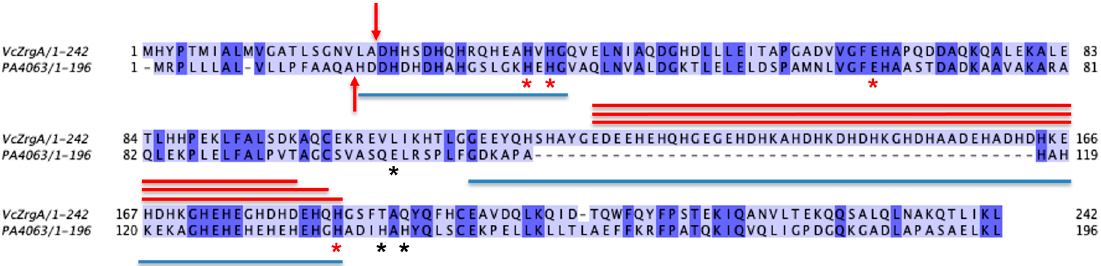
Figure 1. Sequence alignment of ZrgA homologues from V. cholerae (VcZrgA) and P. aeruginosa (PA4063). Arrows indicate predicted cleavage sites for the N-terminal periplasmic targeting se- quence [18,19]. Asterisks indicate zinc binding residues in PA4063 colored by binding site (site a, black; site b, red). Blue lines under the PA4063 sequence indicate unstructured regions in the apo crystal structure. Red lines above the VcZrgA sequence indicate regions deleted in mutants generated in this work.